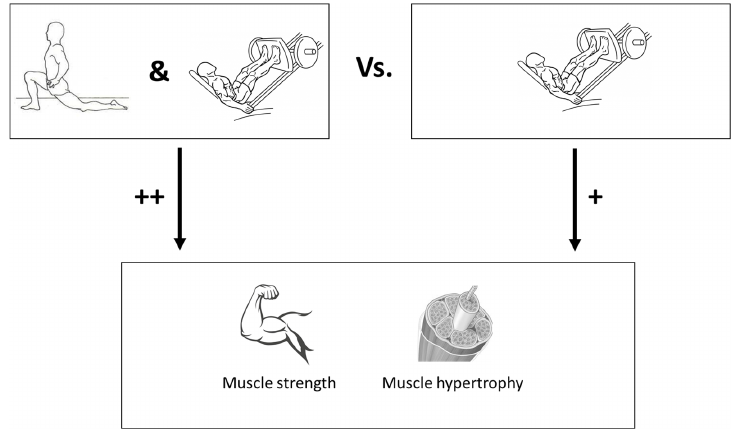
Figure 2. The e ffects of combined resistance training and static stretching versus resistance training only on muscle strength and hypertrophy. Recent evidence indicates an advantage (++) of combin- ing RT with static stretching exercises integrated between the sets compared to resistance training alone (+) [17,18,54] .